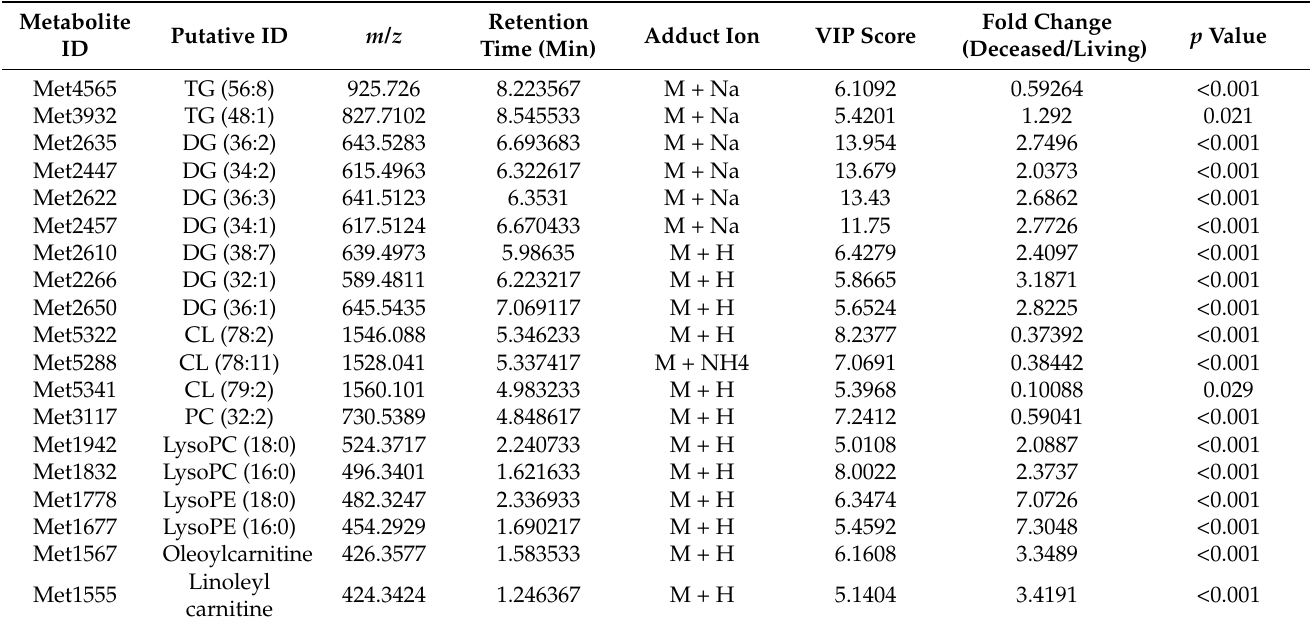
Table 2. The difference of lipidomics in MS-electrospray positive ion mode between deceased and living liver donors.